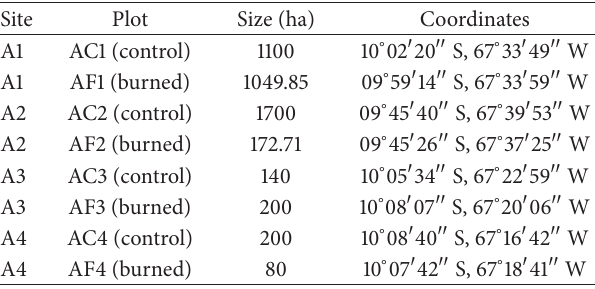
Table 1: Characteristics of the study areas in eastern Acre, Brazil.